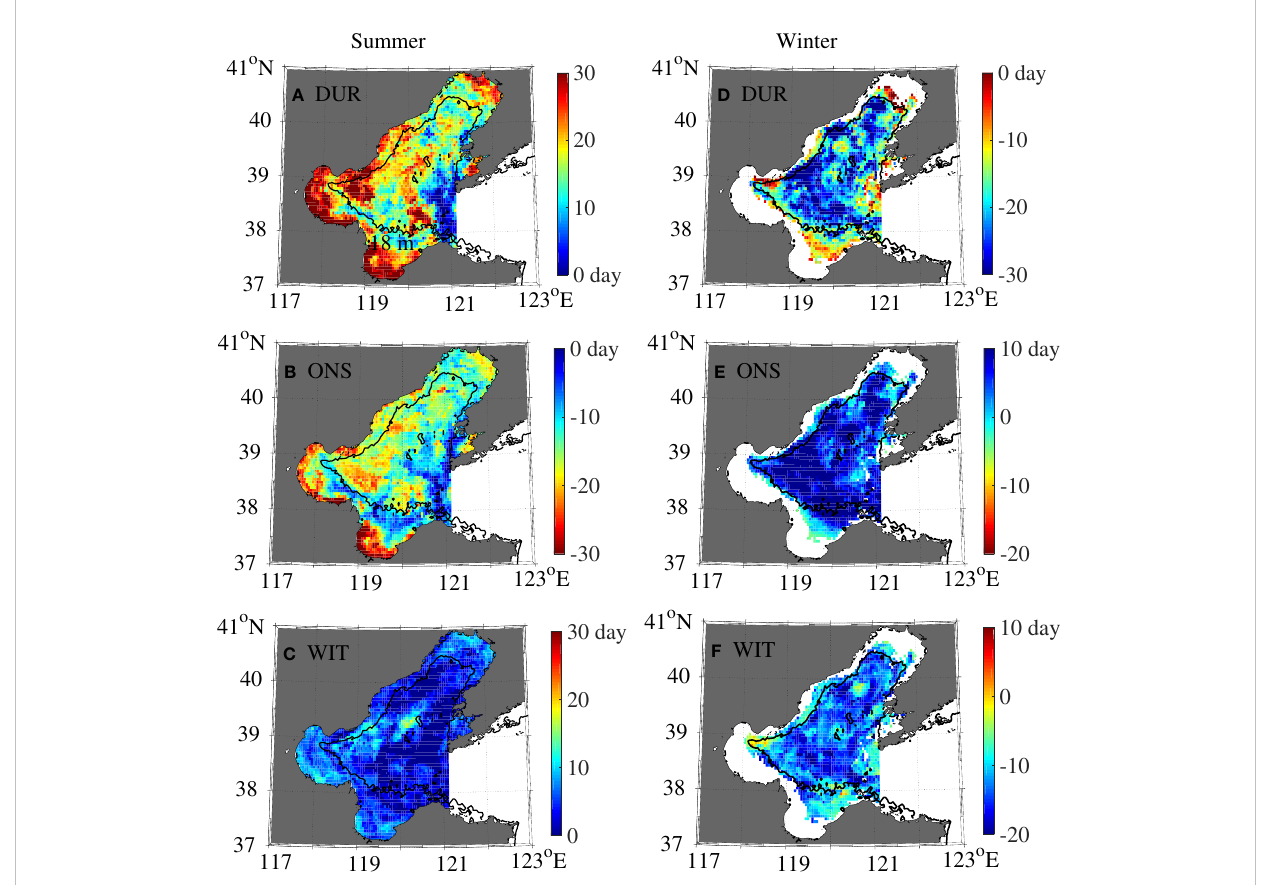
FIGURE 6 Spatial structures of the accumulated variations derived from the secular trends of the (A, D) DUR, (B, E) ONS, and (C, F) WIT for the summer (left panel) and winter (right panel) seasons during the last four decades, respectively. The spatial structures involving winter indices are only shown in the regions without sea ice. Black contour is the same as Figure